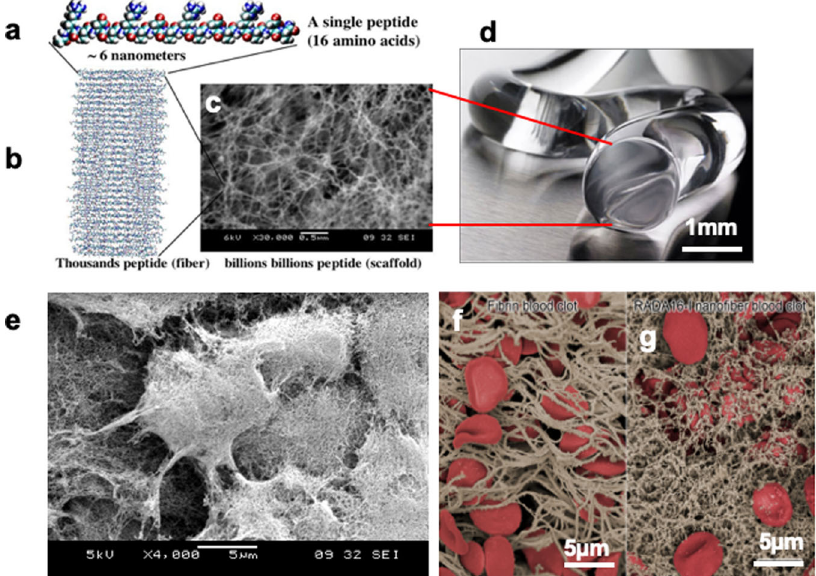
Fig. 1 Beta-sheet self-assembling peptide nano fi ber scaffolds, hydrogel and cells embedded in the scaffold. a Self-assembling peptide RADA16 molecular model. The calculated peptide dimensions are ~6 nm long depending on end capping, 1.3 nm wide and 0.8 nm thick. b Model of thousands of individual peptides as a single nano fi ber. c Trilion of individual peptides self-assemble into nano fi ber scaffold as revealed by the SEM. Scale bar = 0.5 µm. d RADA16-I peptide nano fi bers scaffold hydrogel with extremely high-water content (99.5 – 99.0%, w/ v water). An image of nano fi ber scaffolds hydrogel of RADA16-I at 1% (10 mg/ml), 99% water (image courtesy of 3-D Matrix). e Murine neural stem cells are embedded in the nano fi ber scaffold. The diameter of nano fi ber is in the similar diameter as the cell produced extracellular matrix 8 . f Red blood cells are embedded in the natural fi brin. g Dense RADA16 nano fi ber scaffold 29 . Billions of layers of interwoven nano fi bers tightly keep blood cells in place thus preventing from